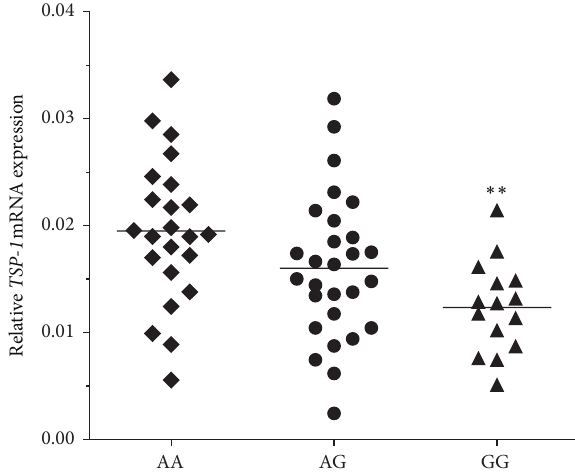
Figure 1: Analysis of TSP-1 mRNA expression levels in three groups of bladder cancer tissue samples with mean values (horizontal lines, mean values). ∗∗ 𝑃 < 0.01 relative to AA genotype.